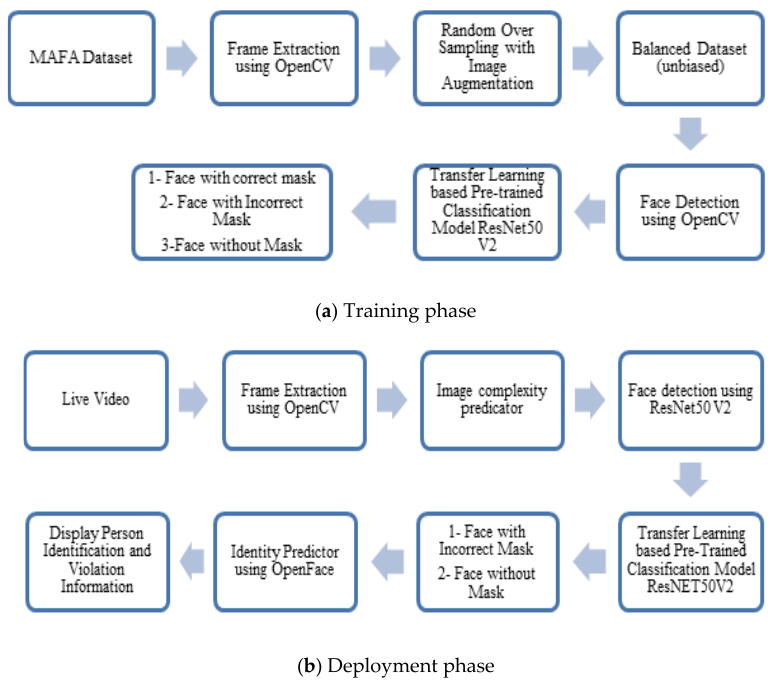
Figure 1. The proposed real ‐ time model for face mask detection. Algorithm 1. Training phase